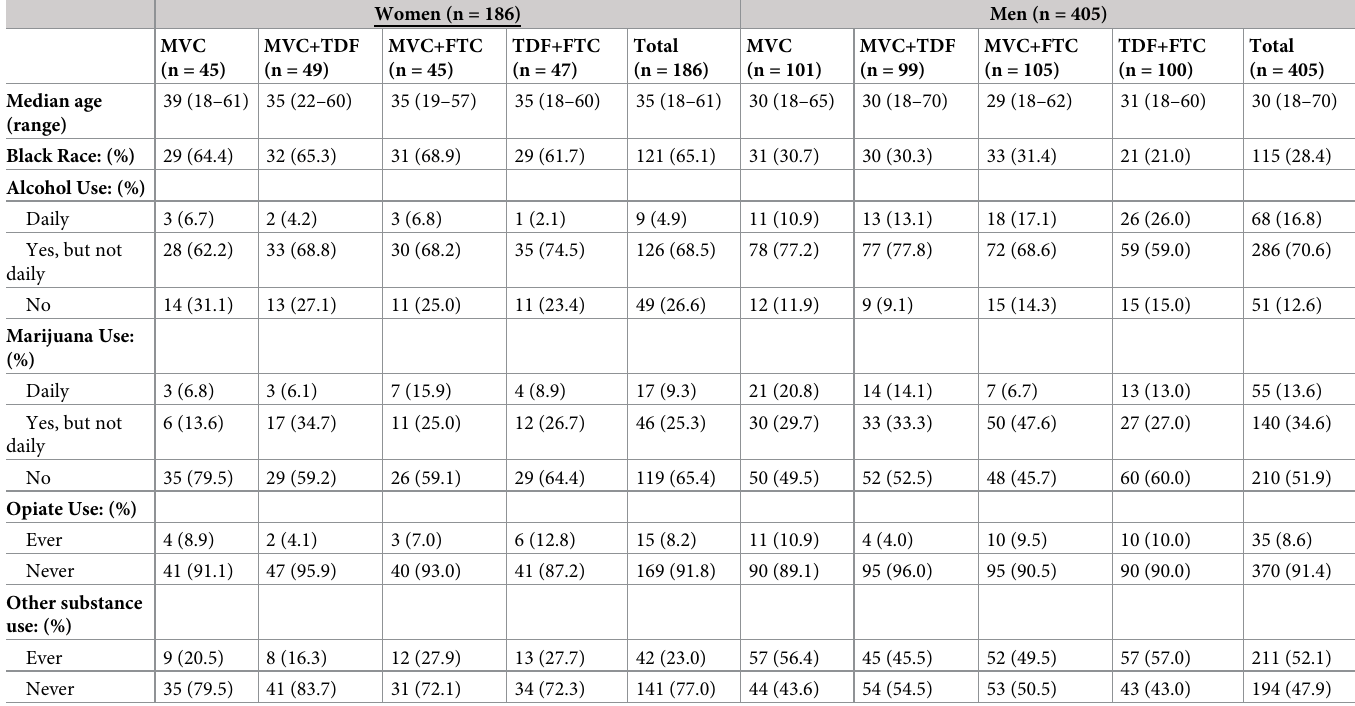
Table 1. Baseline characteristics stratified by sex and randomized regimen.